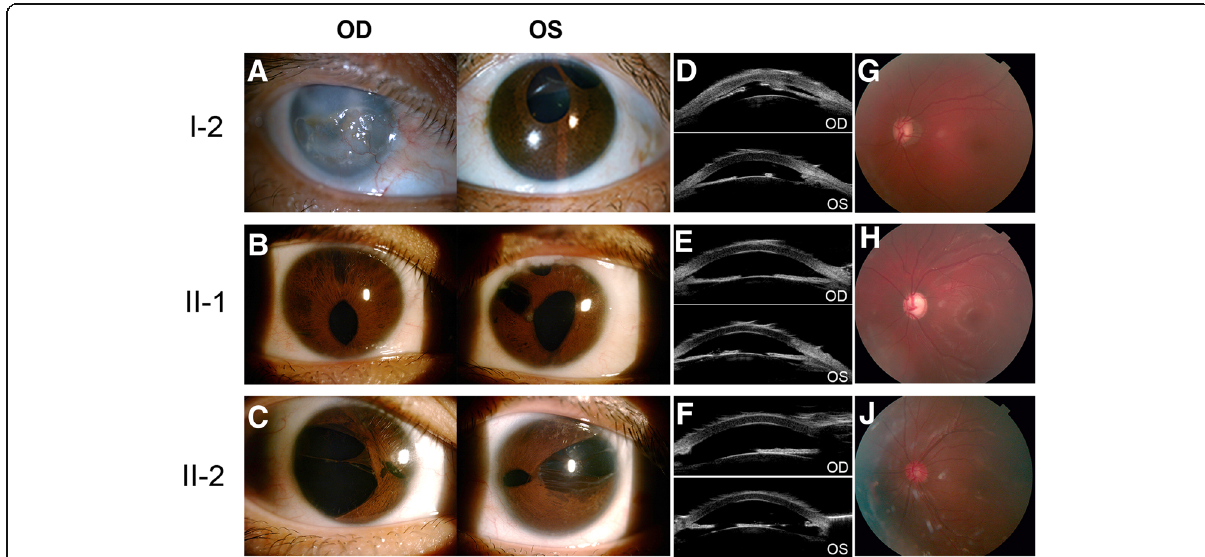
Fig. 2 Ocular clinical features of affected family members with Axenfeld-Rieger syndrome. Anterior segment photography ( a , b and c ) showed different degrees of pupil deformation iris hypoplasia in both eyes and iris atrophy in both eyes for II-1 and II-2 and in the left eye for I-2. Adherent leukoma was observed in the right eye for I-2. Ultrasound biomicroscopy ( d , e and f ) demonstrated a shallow anterior chamber and different degrees of iris atrophy for I-2, II-1 and II-2. Fundus photography ( g , h and j ) of the left eye for the three affected members revealed abnormal CD ratio of 0.8 for I-2, 1.0 for II-1 and 0.5 for